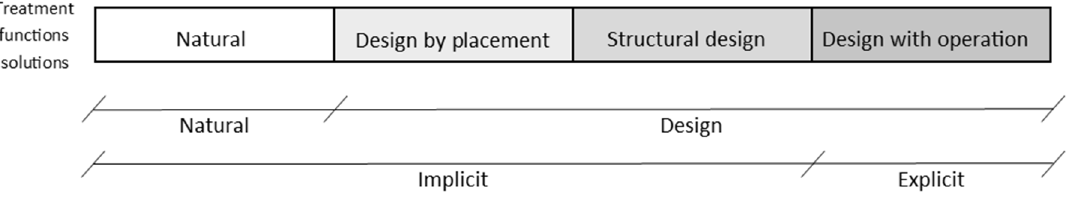
Figure 2. Implicit and explicit treatment function solutions.